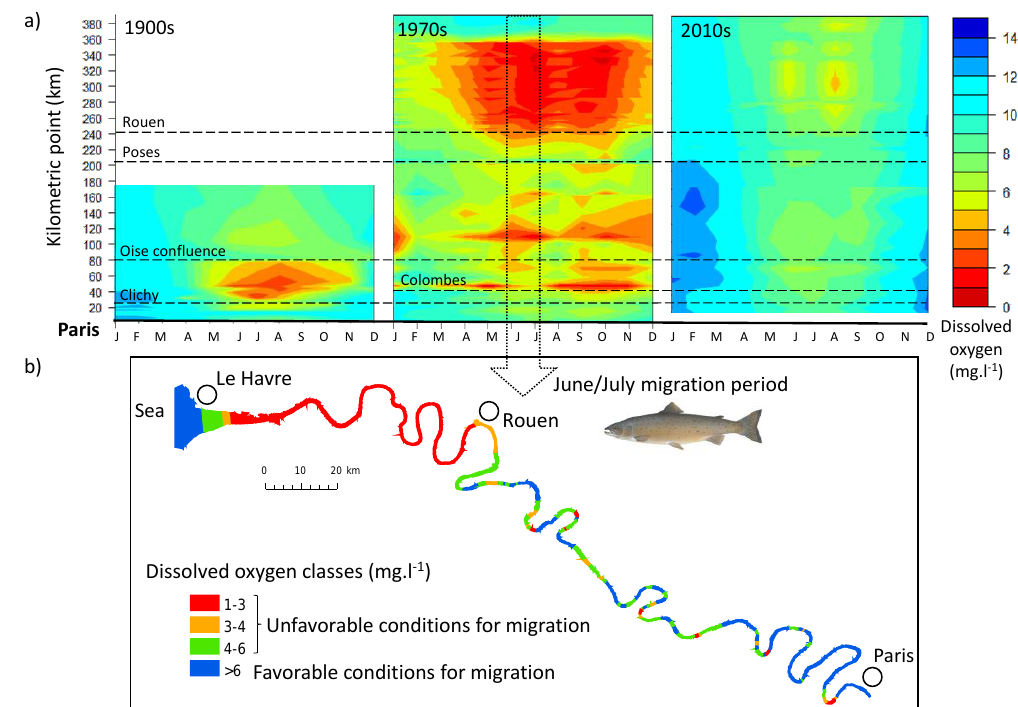
Figure 4. ( a ) Isopleth graphs of dissolved oxygen for the three time periods. Particular kilometric points are represented, referring to Figure 1. ( b ) An example of the longitudinal mean of dissolved oxygen classes (resolution 1 km) in the 1970s for one migration period of Atlantic salmon (June–July).